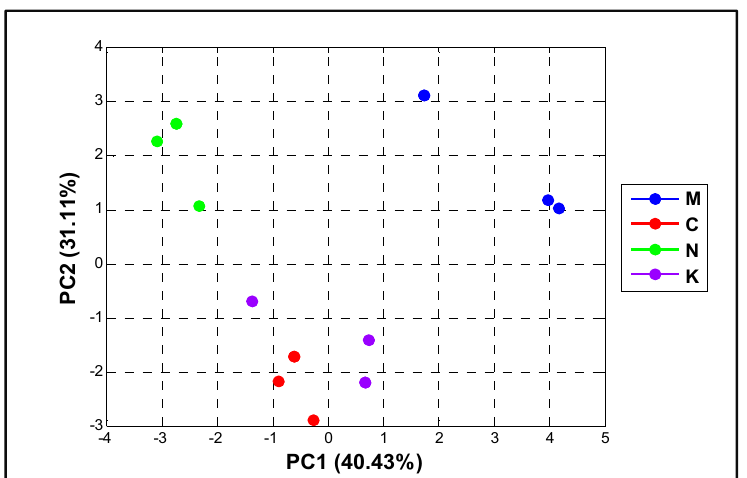
Figure 1. The chemometric PCA score plot based on the physiological characteristics and mango varieties (‘mahachanok’; M, ‘chok anan’; C, ‘nam dok mai’; N, ‘kaew’; K).